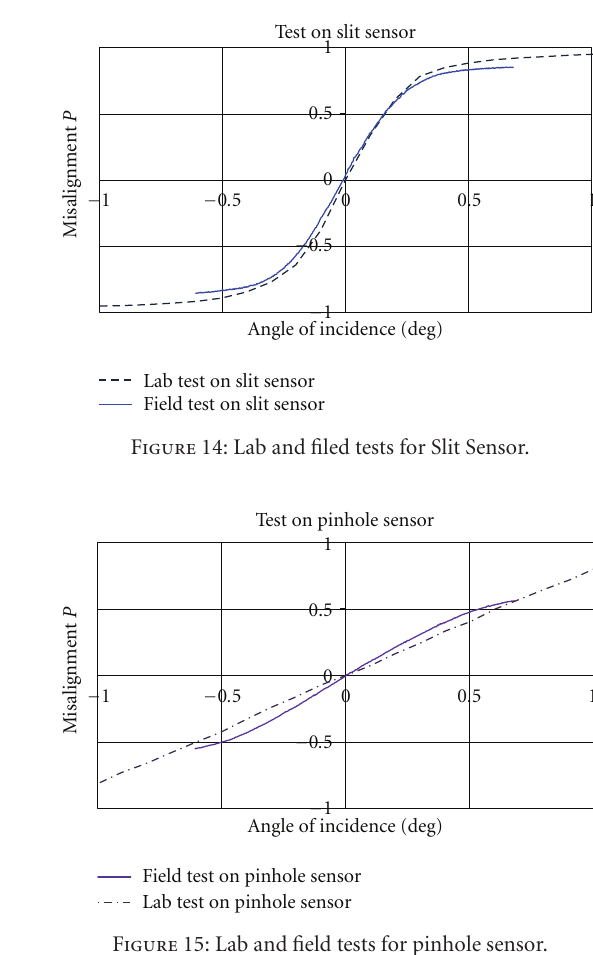
Figure 15: Lab and field tests for pinhole